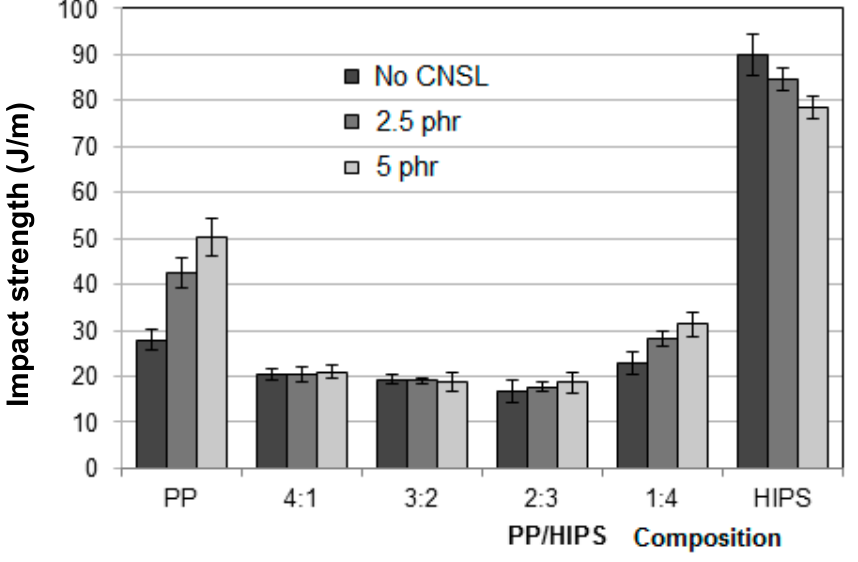
Figure 17. Impact strength results for PP, HIPS and PP / HIPS blends the PP / HIPS blends with 0, 2.5 and 5 phr of CNSL.